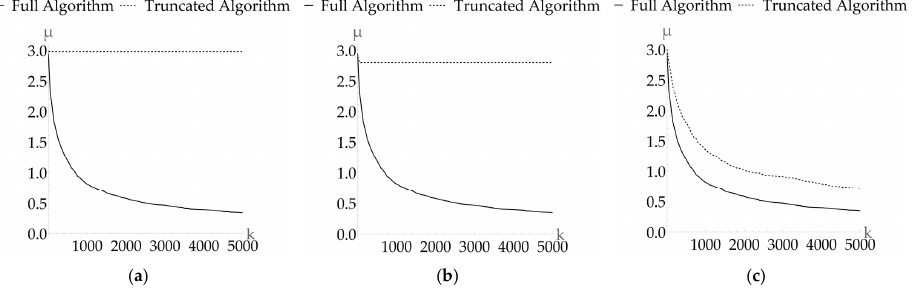
Figure 6. Dependence of the objective function of the best data comparison option on the step number (generation) k when solving the optimization problem: ( a ) without mutation and crossing, ( b ) without mutation, and ( c ) without crossing.